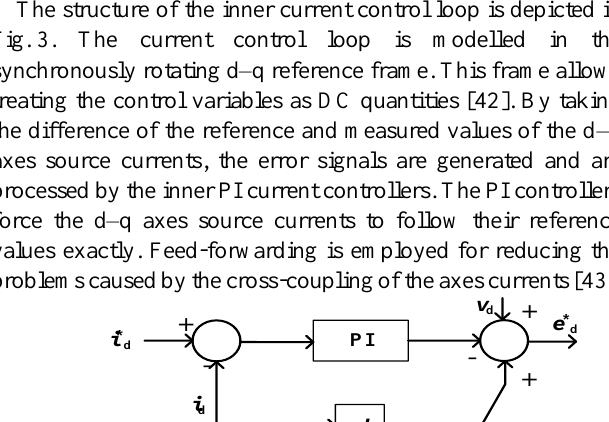
Fig. 5. Block-diagram representation of the inner current control loop.